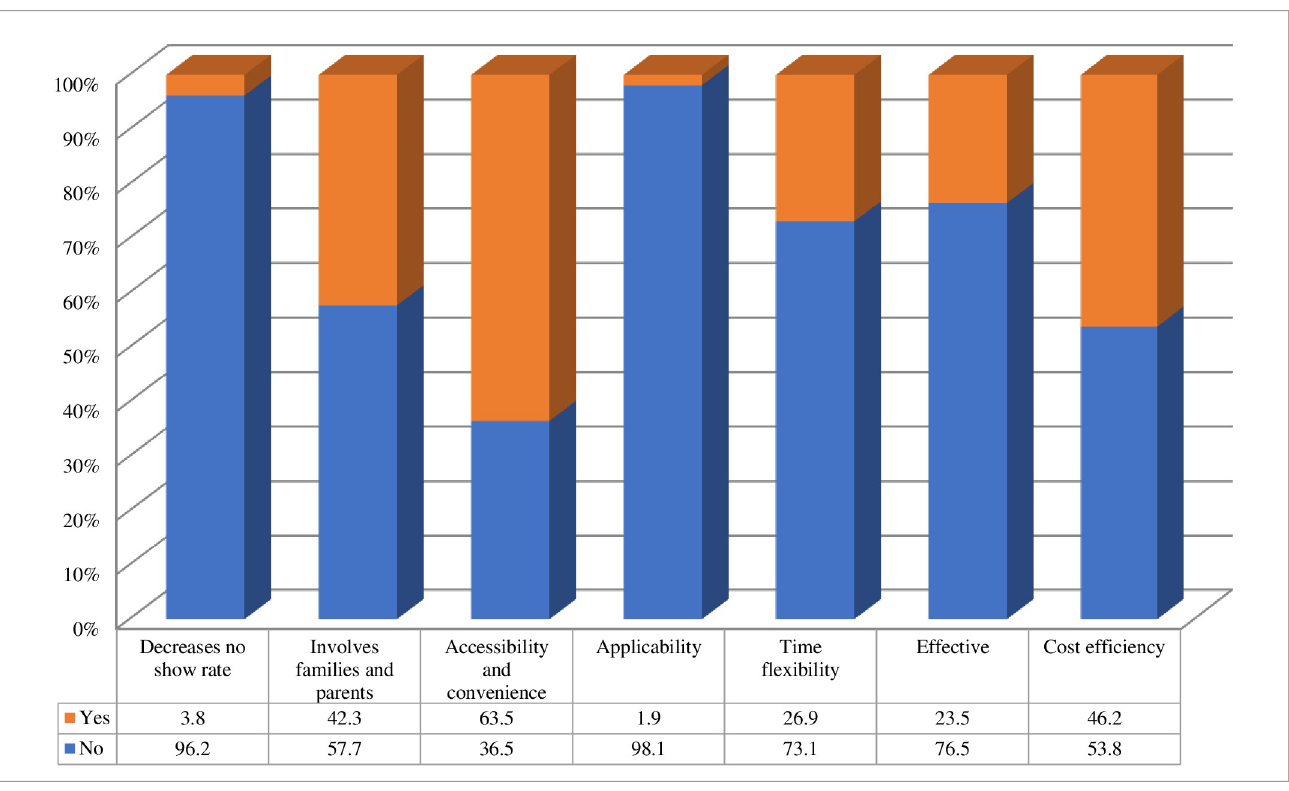
Fig 4. Benefits of telehealth practices (n =